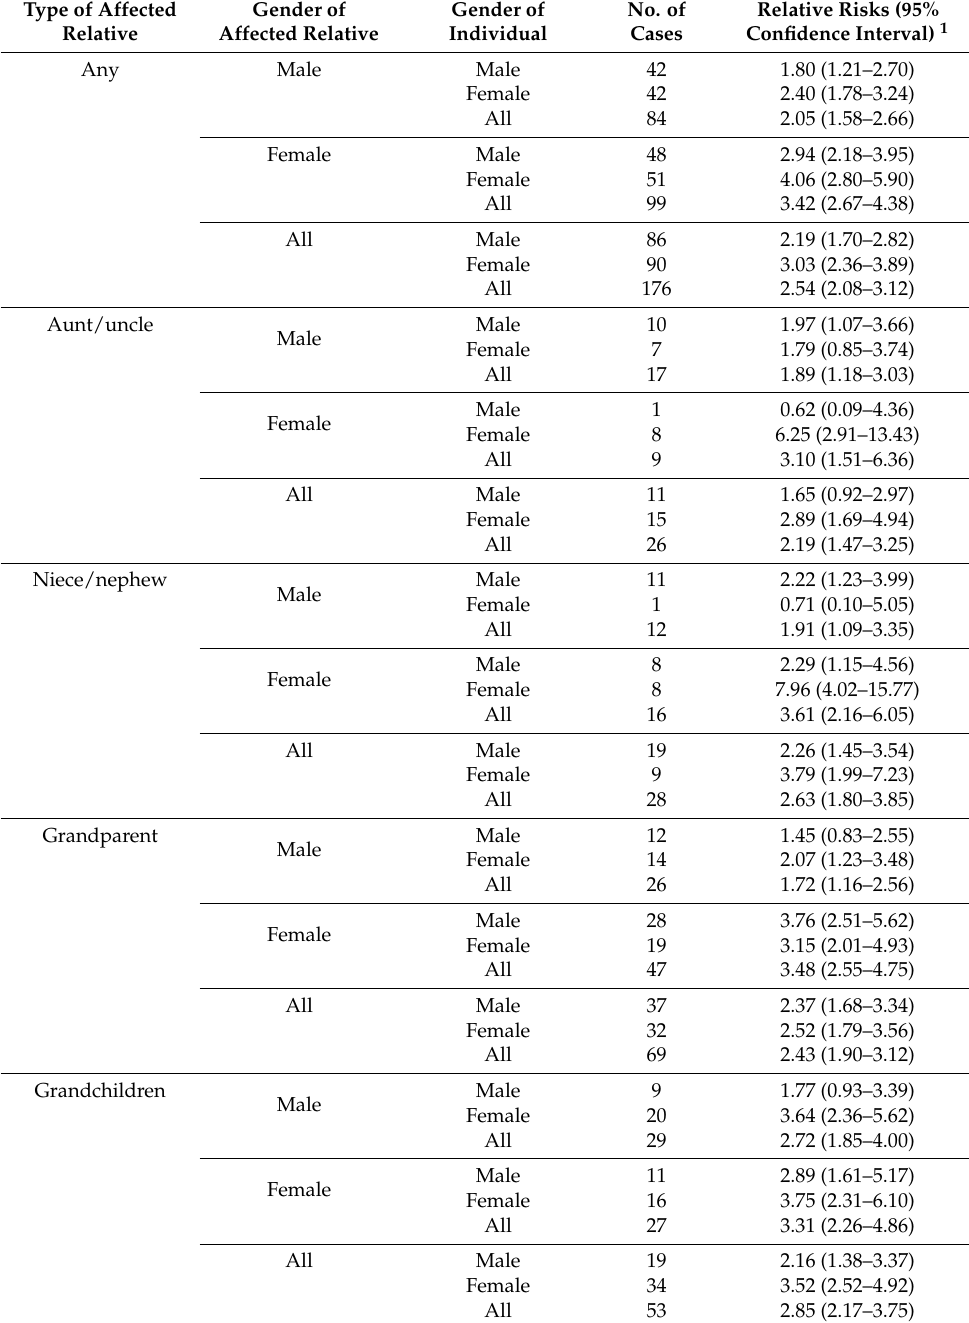
Table 3. Relative risks of psoriasis in individuals with second-degree relatives diagnosed with